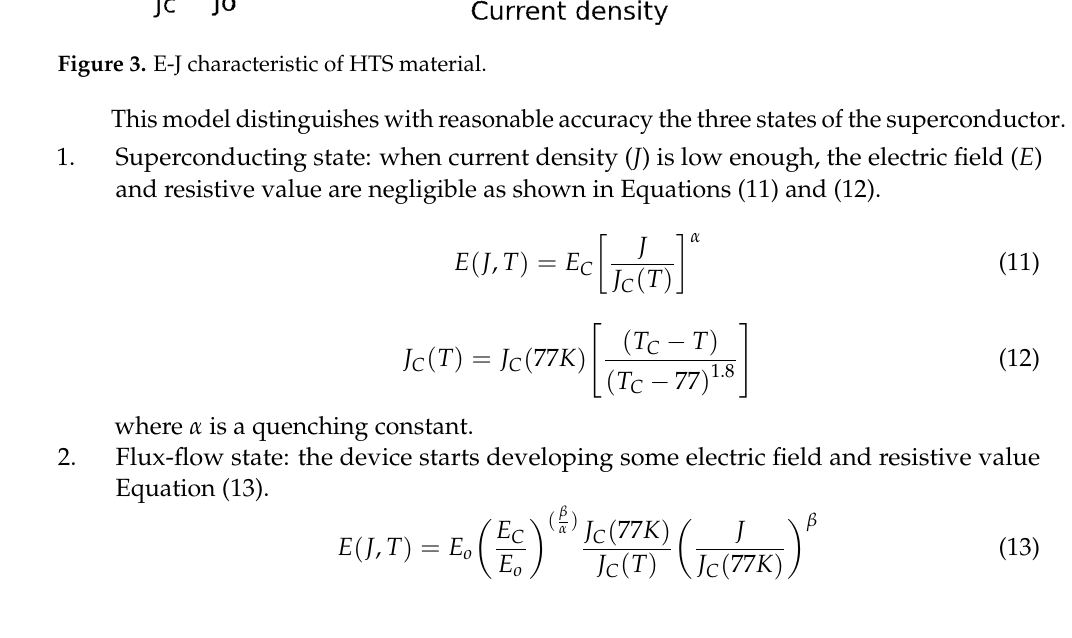
Figure 4. Magneto-Thermal model flow chart. 3. Test Grid and Model Analysis In this section the four R-SFCL models under study are implemented in MATLAB/Simulink and tested in the simplified DC test bed depicted in Figure 5.